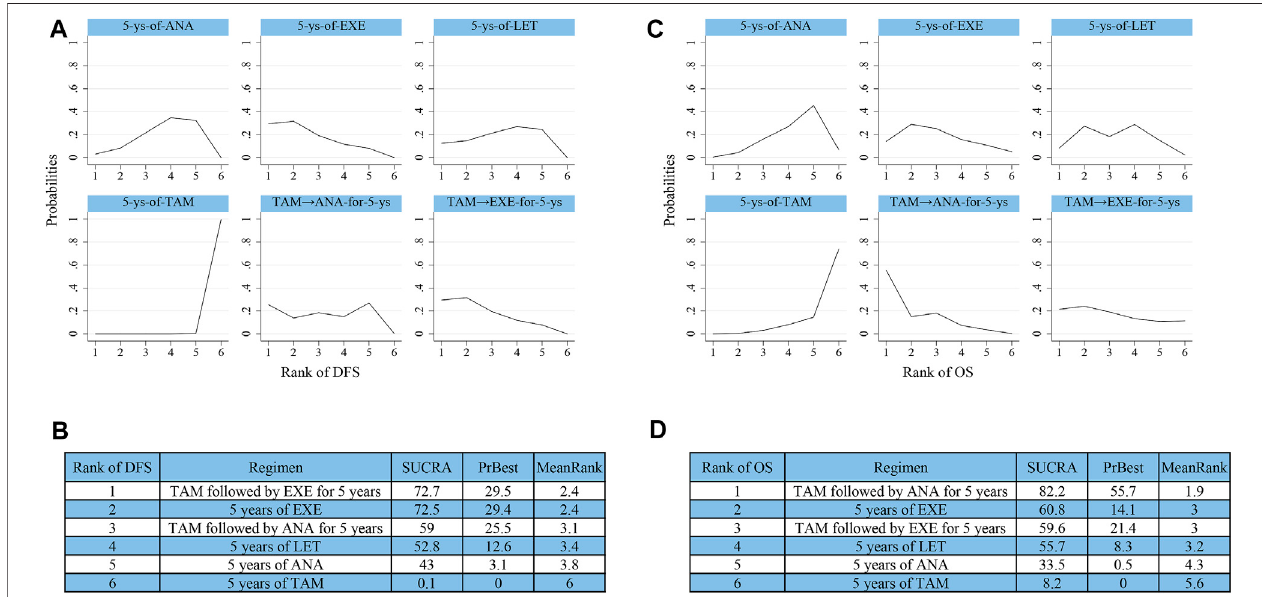
FIGURE 5 | Ranking results of SUCRA for (A,B) DFS and (C,D) OS. Abbreviations: SUCRA, surface under the cumulative ranking curve.